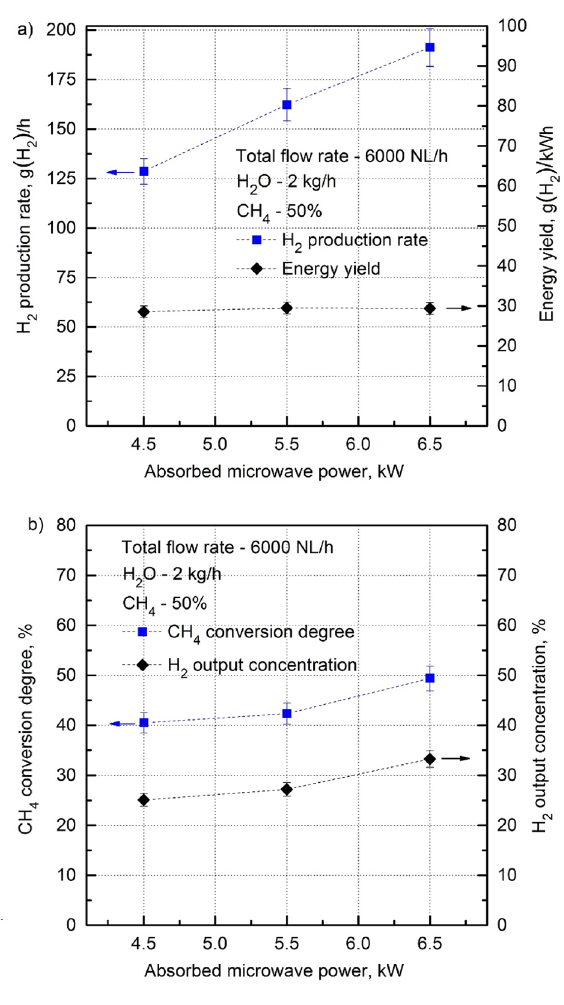
Figure 9. H 2 production rate, energy yield ( a ), CH 4 conversion degree and H 2 output concentration ( b ) as a function of the absorbed microwave power (Total flow rate—6000 NL/h, CH 4 —50%, H 2 O steam —2